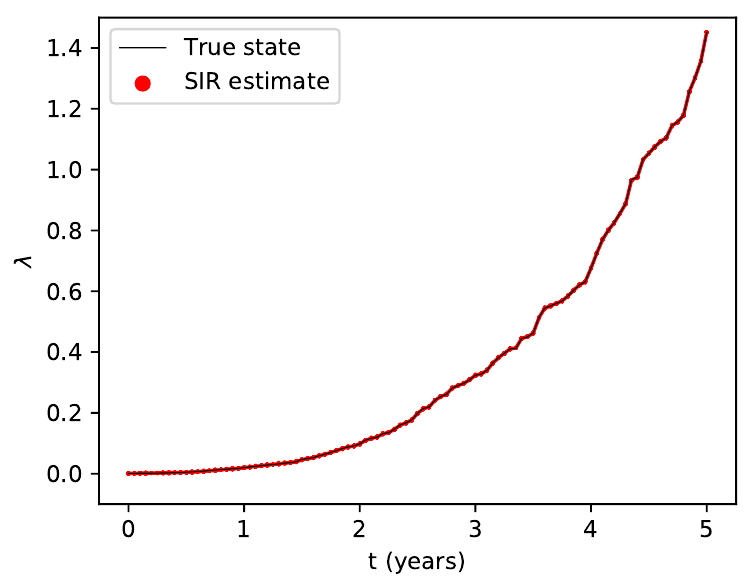
Figure 4. Degradation state online estimation—a posteriori distribution (dot size represents particle weight).